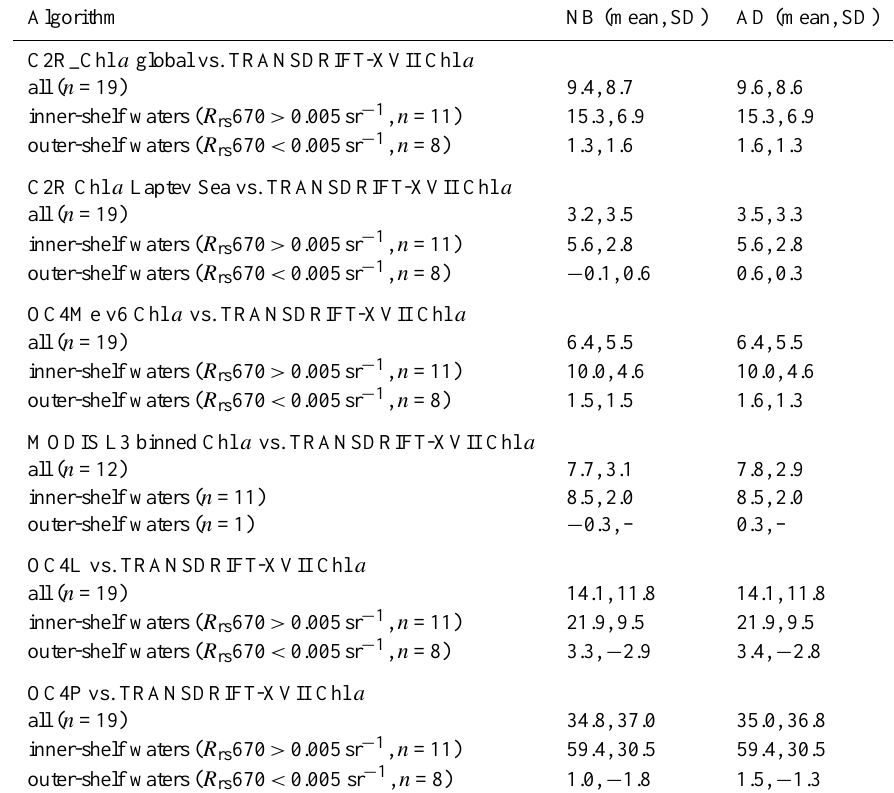
Table 3. Relationships of satellite-derived Chl a vs. in situ TRANSDRIFT Chl a , with the mean normalized bias (NB) (systematic error), the mean absolute difference (AD), and with the standard deviations